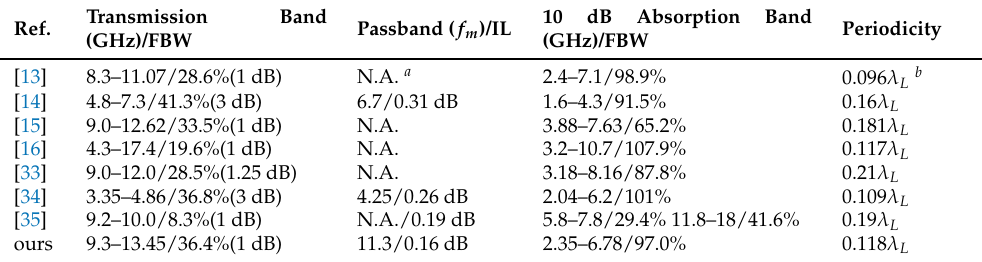
Table 1. Performance comparison between the proposed FSR and other published FSRs.